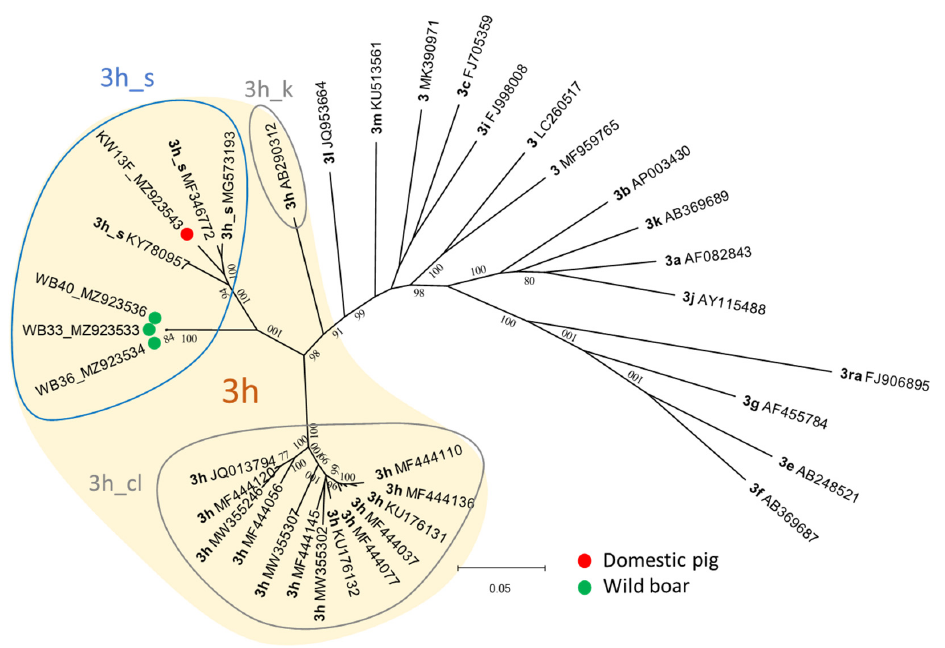
Figure 4. ML tree of the four NGS derived sequences (colored dots) and 32 HEV-3 reference genomes. For the subtype 3h all official references, for all other subtypes the single recommended representatives [39,41] were included. Where necessary, genomes were shortened to identical starting and ending nucleotides (6738-7138 nt length). The evolutionary history was inferred by using the Maximum Likelihood method and Tamura-Nei model [Tamura K. and Nei M. (1993)]. The tree with the highest log likelihood from 1000 bootstrap replicates is shown. The tree is drawn to scale, with branch lengths measured in the number of substitutions per site. Bootstrap values above 80% are shown. The distinct clusters within 3h, namely the classic 3h genomes, the formerly proposed subtypes 3s(p) and 3k(p) are encircled and named 3h_cl, 3h_s and 3h_k, respectively.